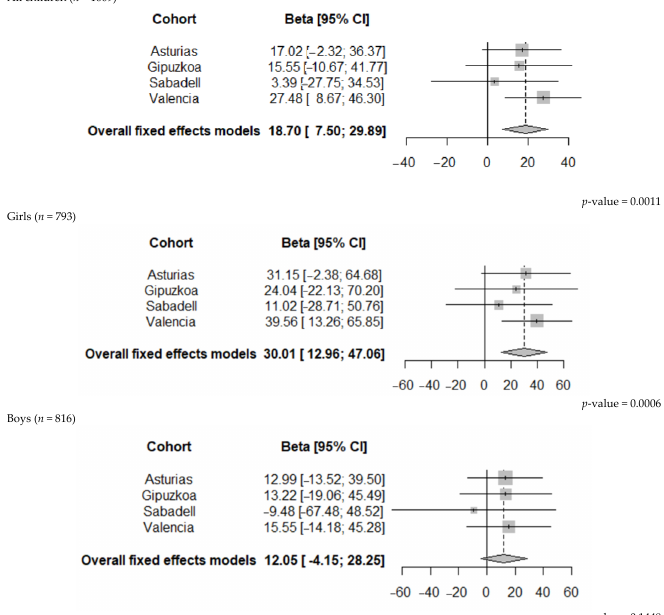
p -value = 0.1448 Figure 2. Pooled estimates of the associations between FAs (<400 μ g/day compared to 400–999 μ g/day) in the second period and alerting in all children, boys, and girls at 7–9 years of age. 3.3. FAs Use during Pregnancy and Cognitive Outcomes in Children by Sex The associations between the maternal FAs use in each period of pregnancy and the of cognitive outcomes at 7–9 y are shown in Table 3 for the girls and in Table 4 for the boys.